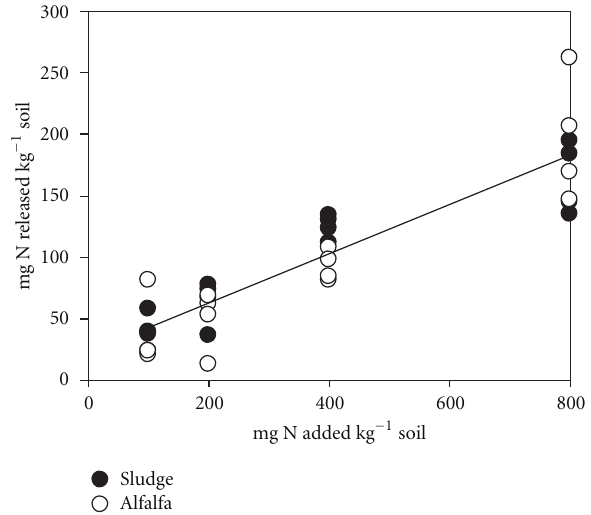
Figure 3: Incubation experiment one. Relation of N added to total mineral N released after 28 days for incubations of sludge and alfalfa with soil calculated with subtraction of mineral N in control incubations. The fitted regression line y = 20 . 0 + 0 . 20 x of r 2 = 0 . 81 for the data pooled across sludge and alfalfa amendments is significant ( P < 0 . 001). Table 3: Incubation experiment two. Ammonium-N and nitrate- N mineralized from di ff erent screen fractions of sludge applied at 400mgN kg − 1 dry soil, as compared to controls with no sludge added. Means in a column followed by di ff erent letters (a, b, and c for NH 4 –N; x, y, and z for NO 3 –N) are significantly di ff erent at the 5% probability